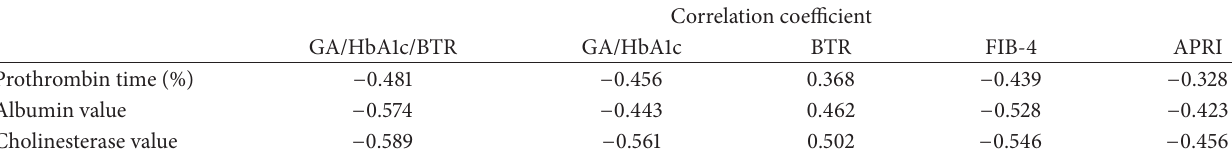
Table 3: Correlation of the three biomarkers with liver function parameters in HCV-positive patients. Correlation